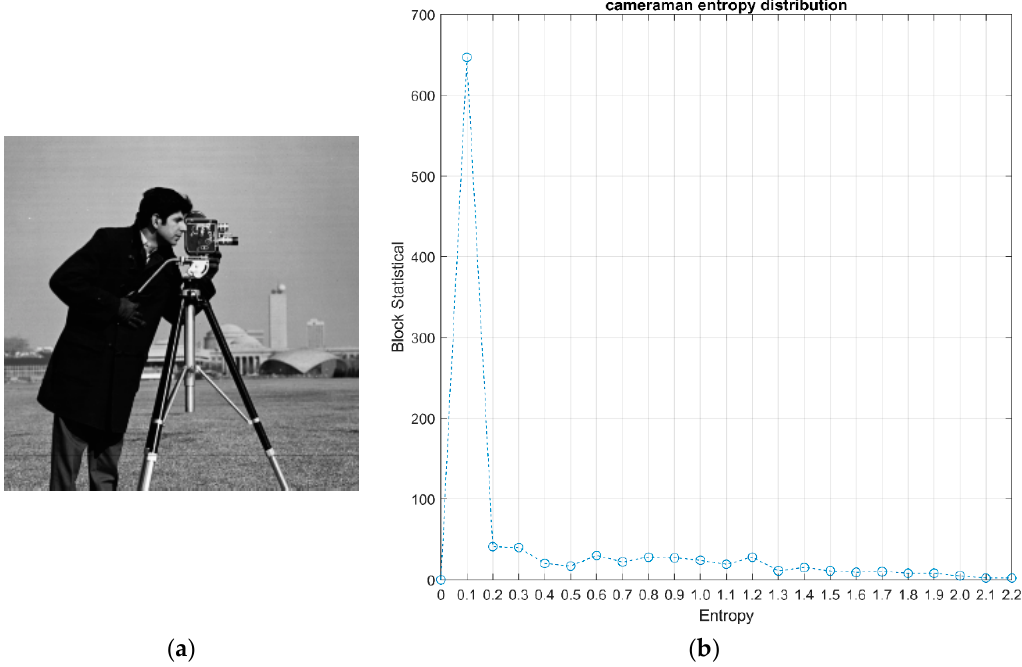
Figure 2. The test image cameraman: ( a ) original image with a size of 256 × 256; and ( b ) the entropy distribution.